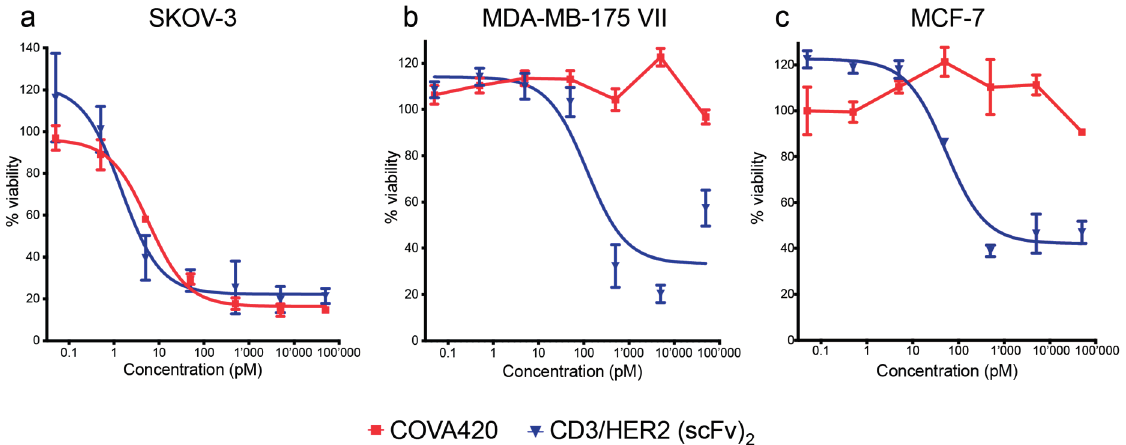
Figure 4. Redirected T cell cytotoxicity assay in dependence of HER2 expression levels. Effector CD8+ T cells were incubated in the presence of COVA420 (red) or CD3/HER2 (scFv) 2 (blue) with target cell lines with decreasing HER2 expression levels (( a ) SKOV-3, HER2 high; ( b ) MDA-MB-175 VII, HER2 intermediate; ( c ) MCF-7, HER2 low). Redirected T cell cytotoxicity was assessed by XTT conversion. Data were normalized as described in the experimental section and plotted as mean ± SD.